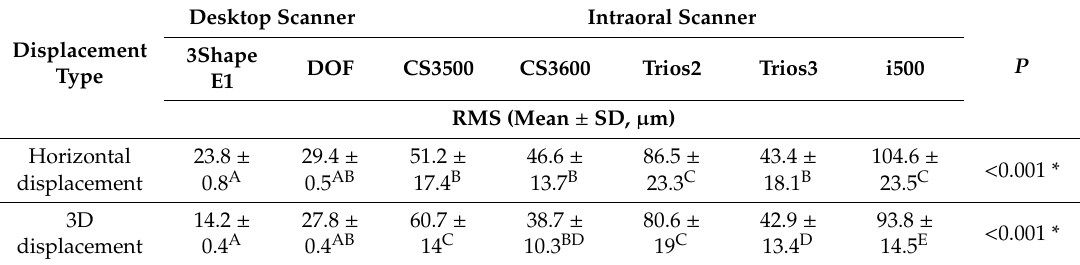
Table 1. Horizontal displacement and 3D displacement according to the 3D scanners.